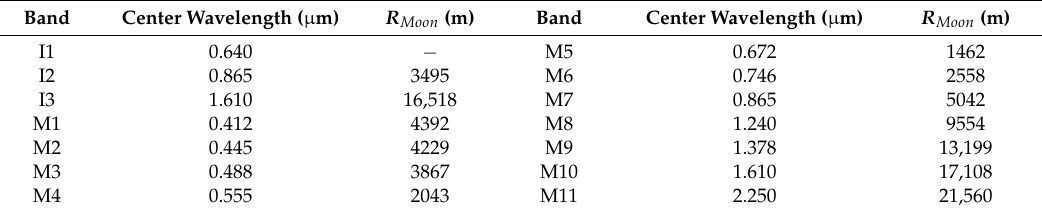
Table 2. The centroid displacement on the lunar surface (at the phase around ´ 51